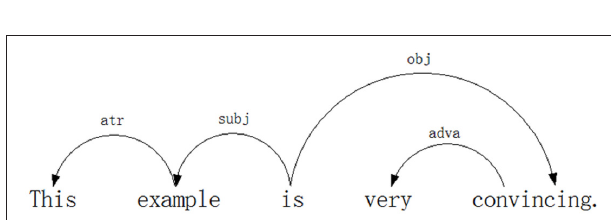
FIGURE 1 | Dependency analysis of the sentence “ This is an example. ”